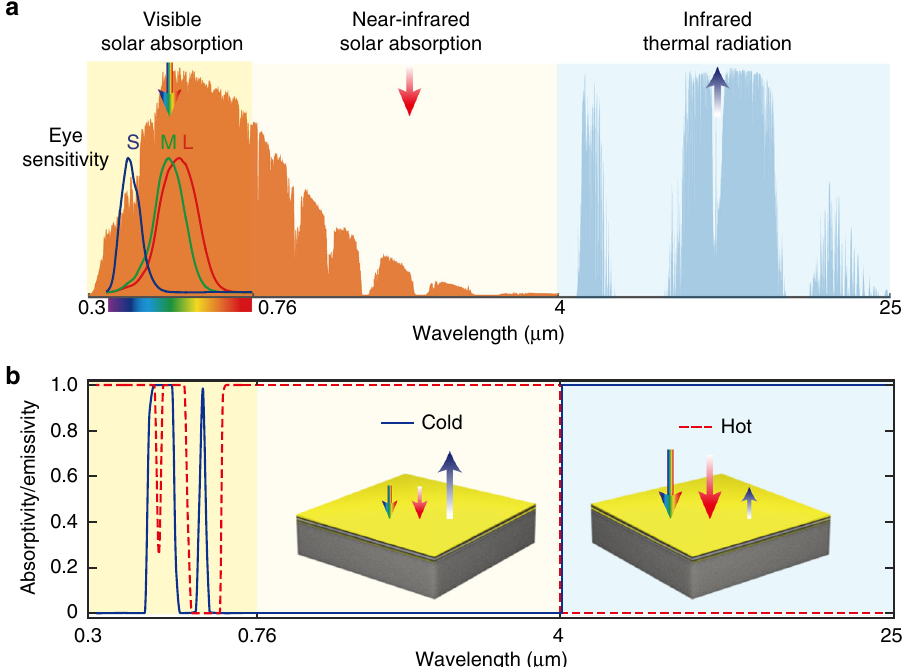
Fig. 1 Mechanisms for photonic thermal management of a coloured object. a Three important mechanisms: visible solar absorption, near infrared solar absorption and infrared thermal emission for colour-preserving photonic thermal management in the visible, near infrared and thermal wavelength range. The human eye sensitivity spectra of three receptors with short ‘ S ’ (blue curve), middle ‘ M ’ (green curve) and long ‘ L ’ (red curve) sensitivities 29 , AM 1.5 G solar spectrum (orange shaded area), and atmosphere transmittance 28 (light blue shaded area) are plotted for references. b Exemplary absorptivity/ emissivity spectra of two surfaces with the same ‘ gold ’ colour but signi fi cantly different thermal properties. The ‘ cold ’ surface (blue curve, left inset) has high re fl ection/low absorption in visible and near infrared wavelength range, as well as high thermal emission in the wavelength range. The ‘ hot ’ surface (dashed red curve, right inset) has low re fl ection/high absorption in visible and near infrared wavelength range, as well as low thermal emission in the thermal wavelength